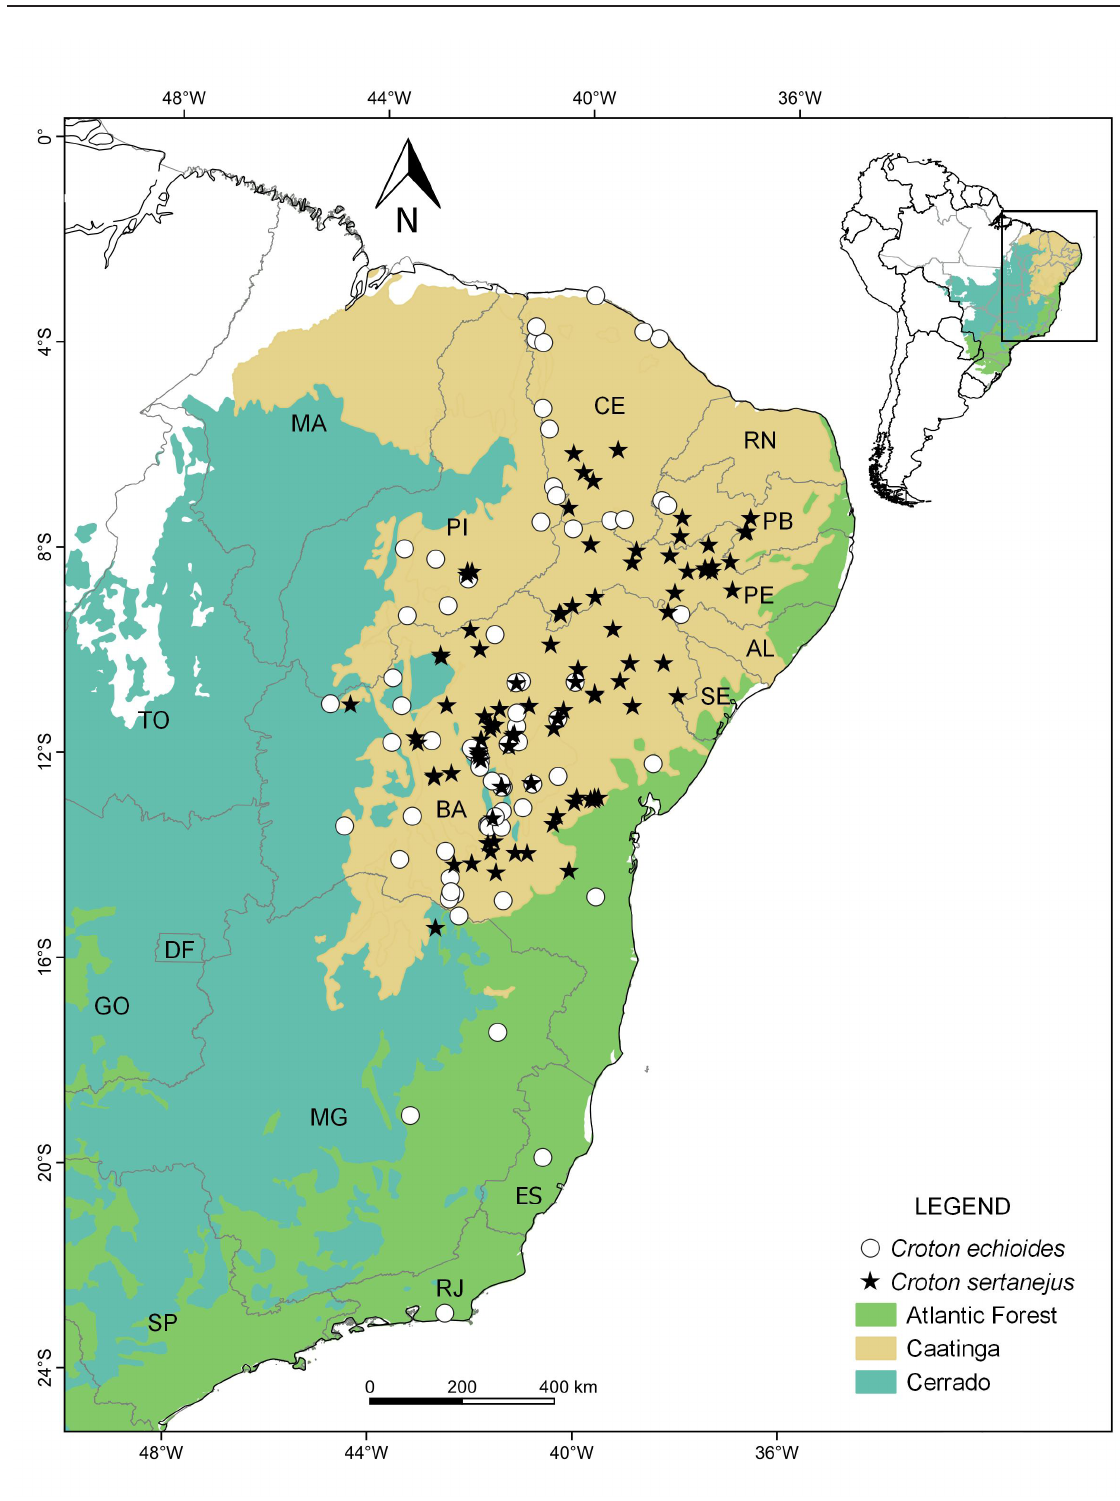
Fig. 3. Geographical distribution of Croton echioides Baill. and C. sertanejus Sodré & M.J.Silva sp. nov. Ecoregions classified according to Dinerstein et al. (2017) (avaliable at https://ecoregions2017.appspot.com). Abbreviations for Brazilian States: AL = Alagoas; BA = Bahia; CE = Ceará; ES = Espirito Santo; DF = Federal District; GO = Goiás; MA = Maranhão; MG = Minas Gerais; PB = Paraíba; PE = Pernambuco; PI = Piauí; RJ = Rio de Janeiro; RN = Rio Grande do Norte; SE = Sergipe; SP = São Paulo; TO =